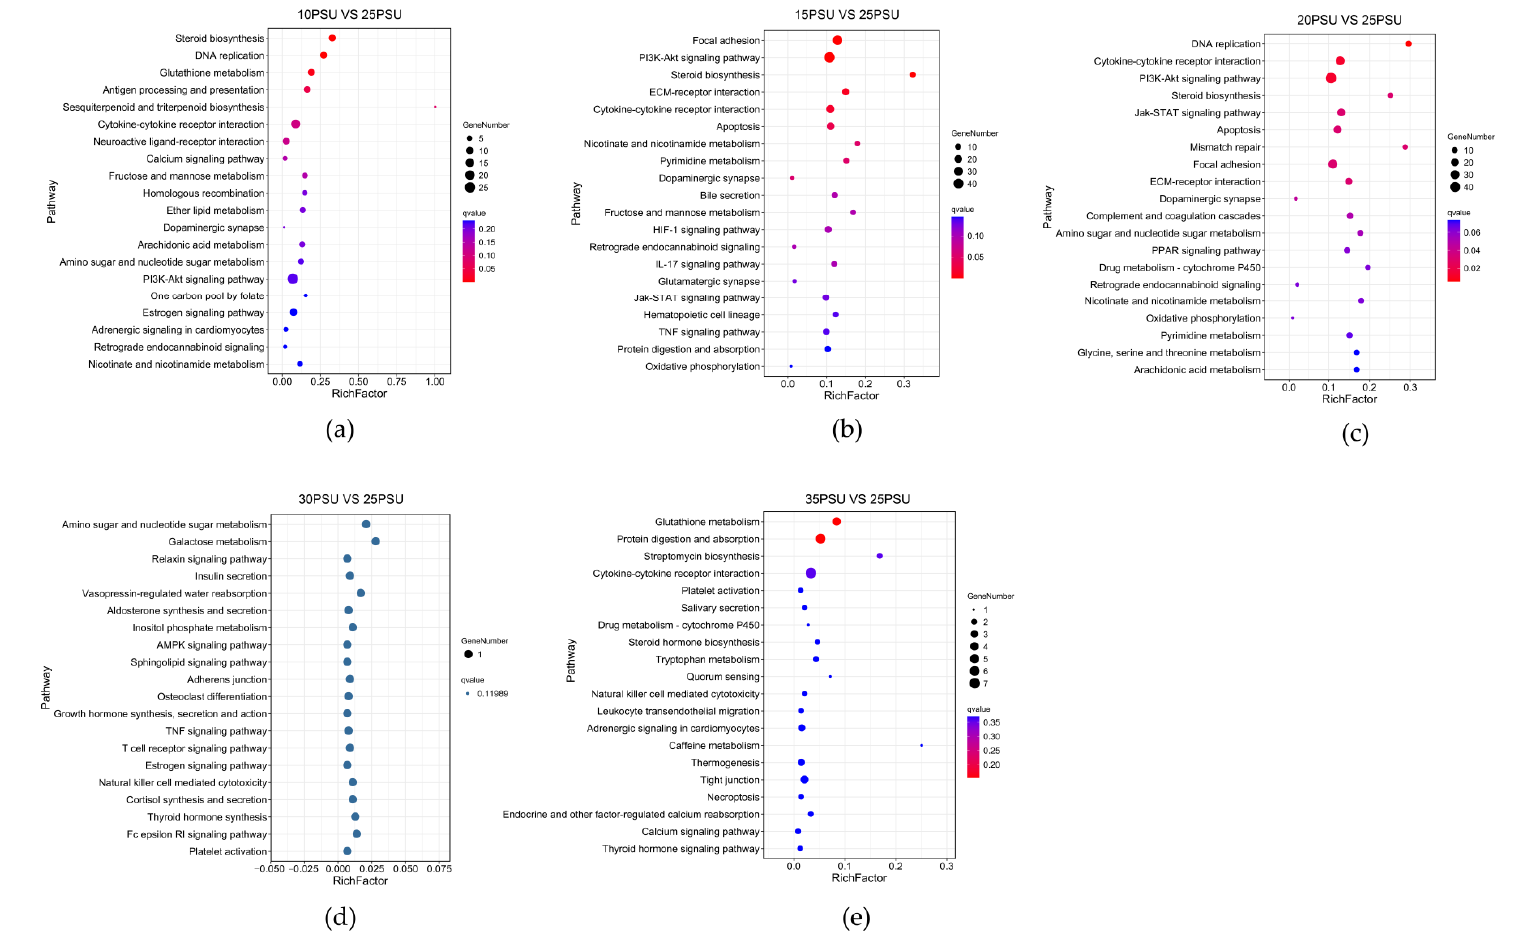
Figure 4. The results of the KEGG pathway enrichment analysis of DEGs in the yellow drum under salinity fluctuations. (The size of the bubble indicates the number of genes enriched to a KEGG pathway, the color represents the Q-value, and the redder the color is, the smaller the Q-value). ( a ) 10PSU vs. 25PSU; ( b ) 15PSU vs. 25PSU; ( c ) 20PSU vs. 25PSU; ( d ) 30PSU vs. 25PSU; ( e ) 35PSU vs.